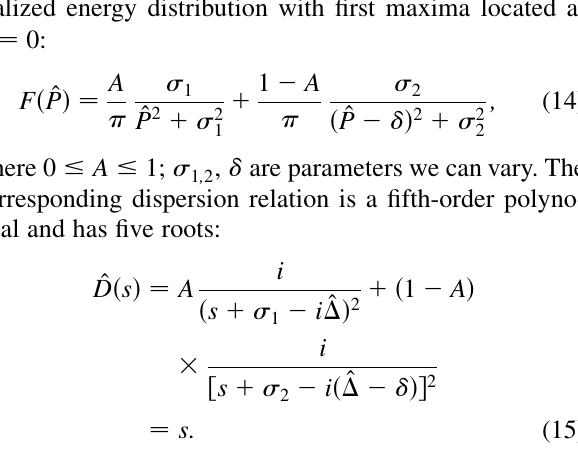
FIG. 5. (a) Bi-Lorentzian energy distribution with A ¼ 0 : 5 ; (cid:9) dispersion relation (15) as functions of the